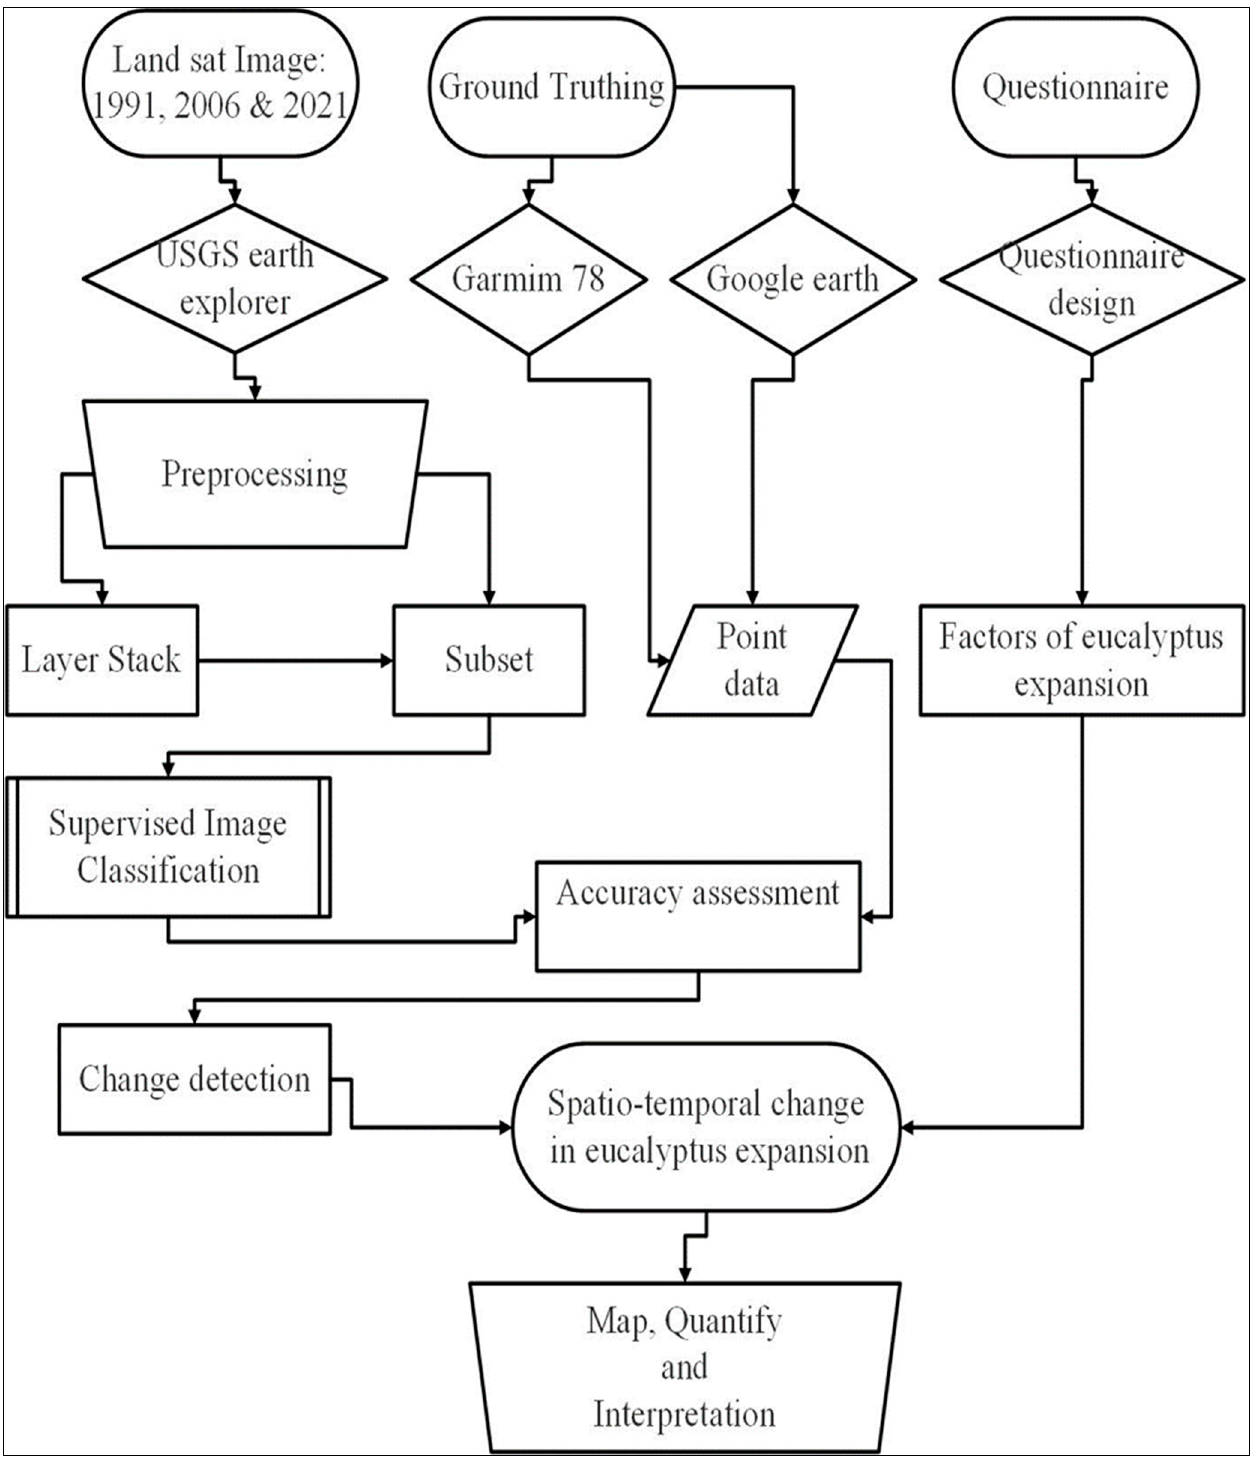
Figure 4. Methodological Flowchart implemented for the study.